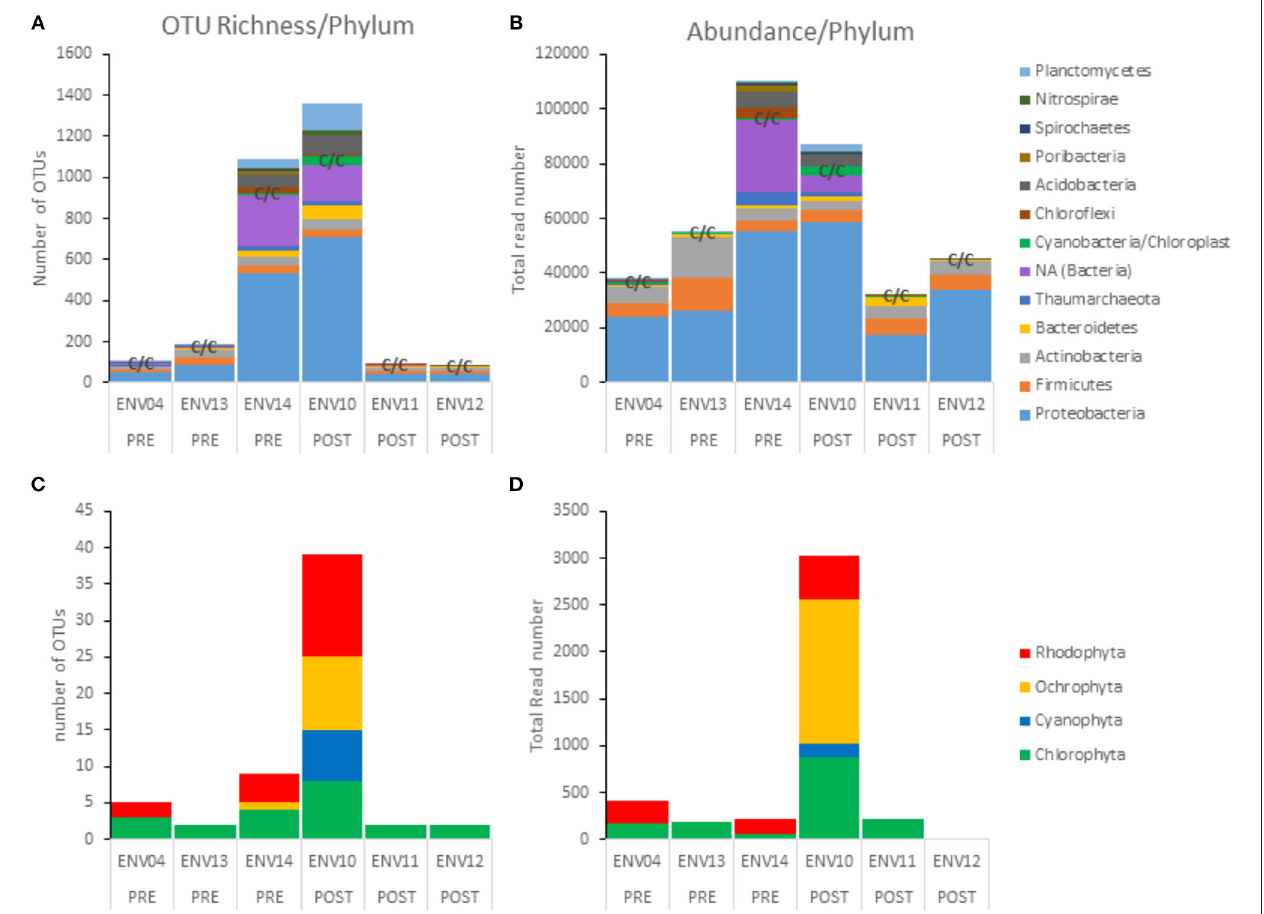
FIGURE 9 | Phototroph richness (OTU number) and abundance (read counts) retrieved with 16S V4 rDNA from pre- and post-DWH rhodolith endolithic communities. (A,B) All phyla. (C,D) Phototrophic phyla only. Note the relatively small number of OTUs and abundance of phototrophic OTUs (C/C for Cyanobacteria/Chloroplast) as compared to heterotrophic phyla.